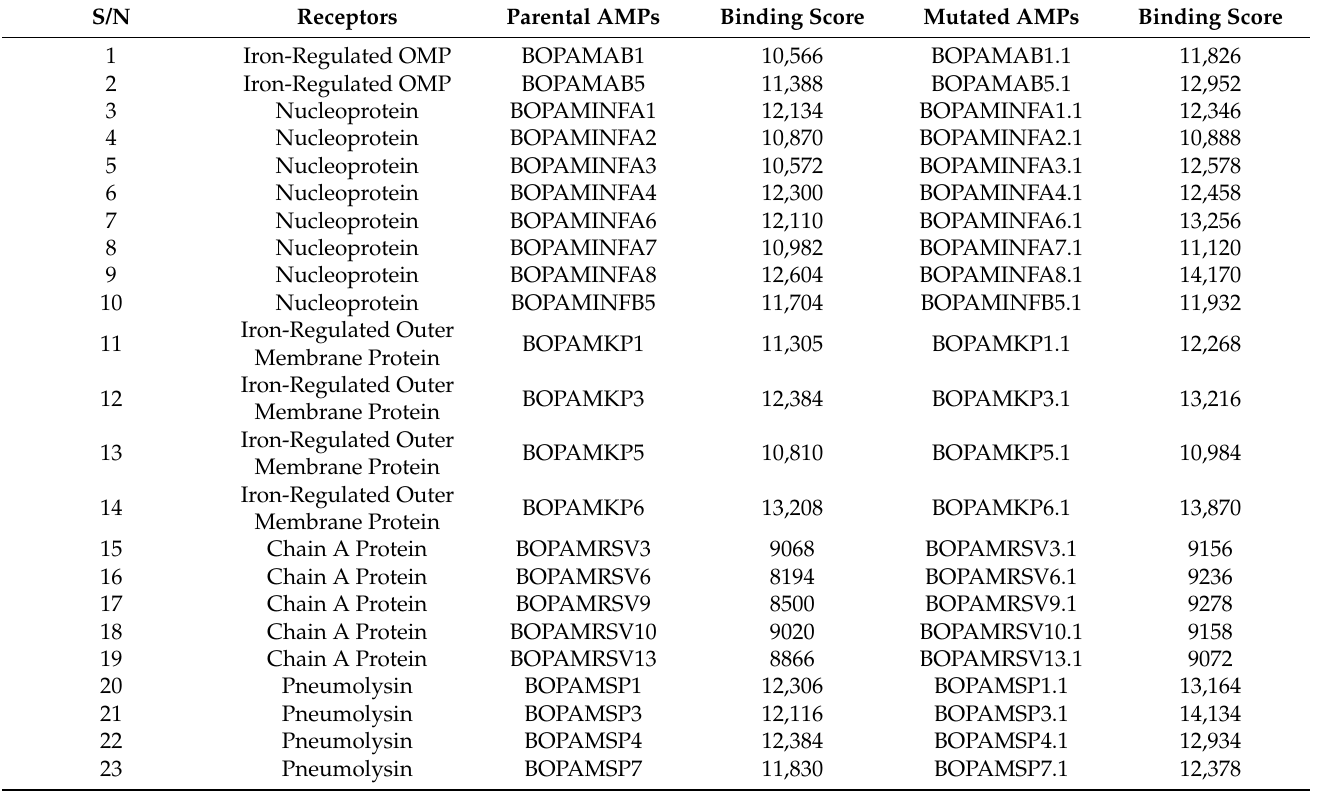
Table 5. Docking analysis only of derivative viral and bacterial anti-pneumonia AMPs and their receptors which showed increased binding